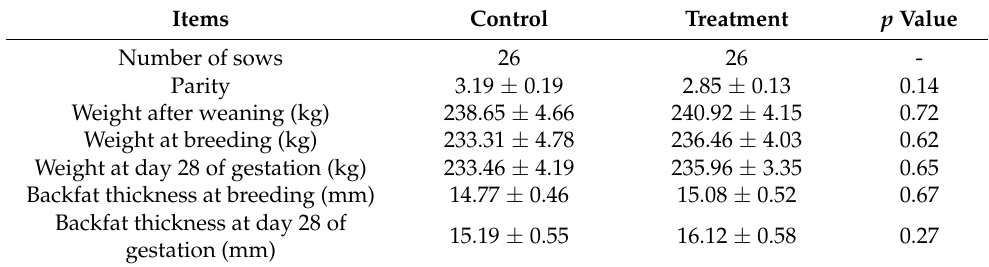
Table 3. Effects of medium- and short-chain fatty acid combination on body condition of sows 1,2.